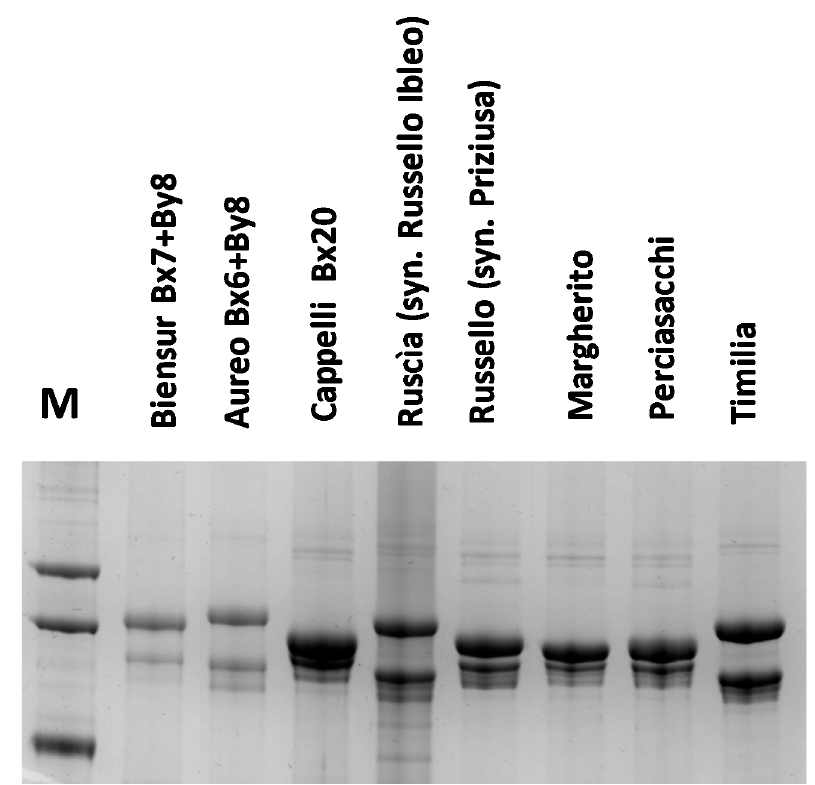
Figure 1. HMW-GS extracted from three commercial varieties of durum wheat (Biensur, Aureo, Cappelli) and from the durum wheat reference seeds (Ruscìa, Russello, Margherito, Perciasacchi and Timilia) obtained from CREA. M: markers weight.